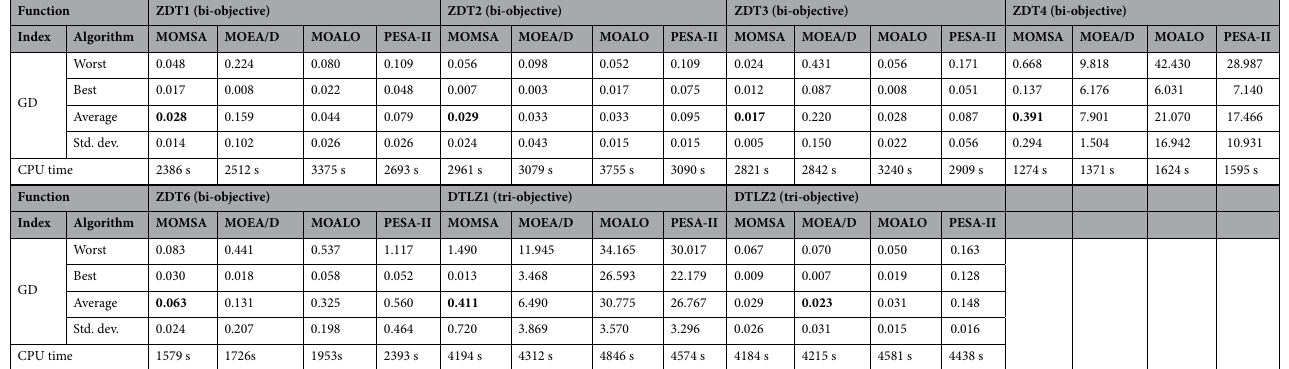
Table 5. Statistical results for GD evaluation metrics on ZDT bi-objective and DTLZ tri-objective test function suite. The bold values in the table represnt the best values obtained by the utilized algorithms for each benchmark function.